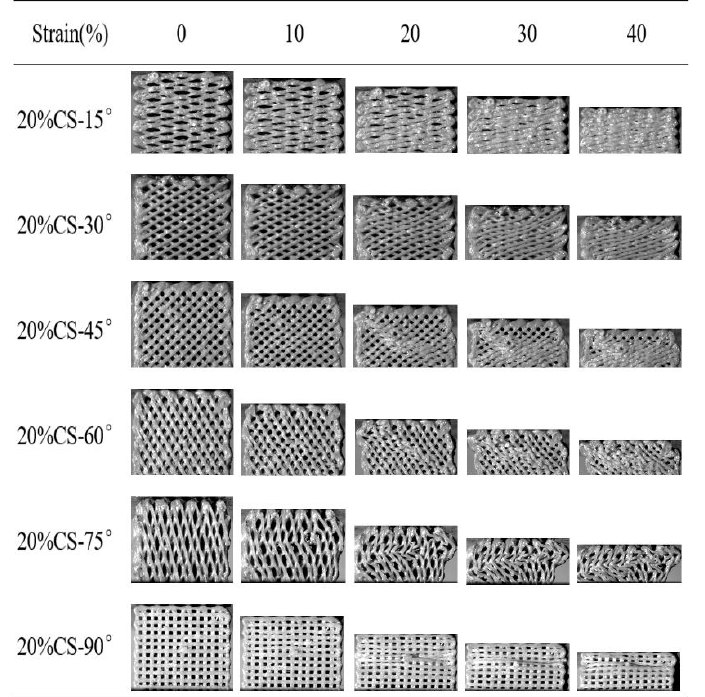
Figure 6. The compressive process of the 20%CS scaffolds with different raster angles.